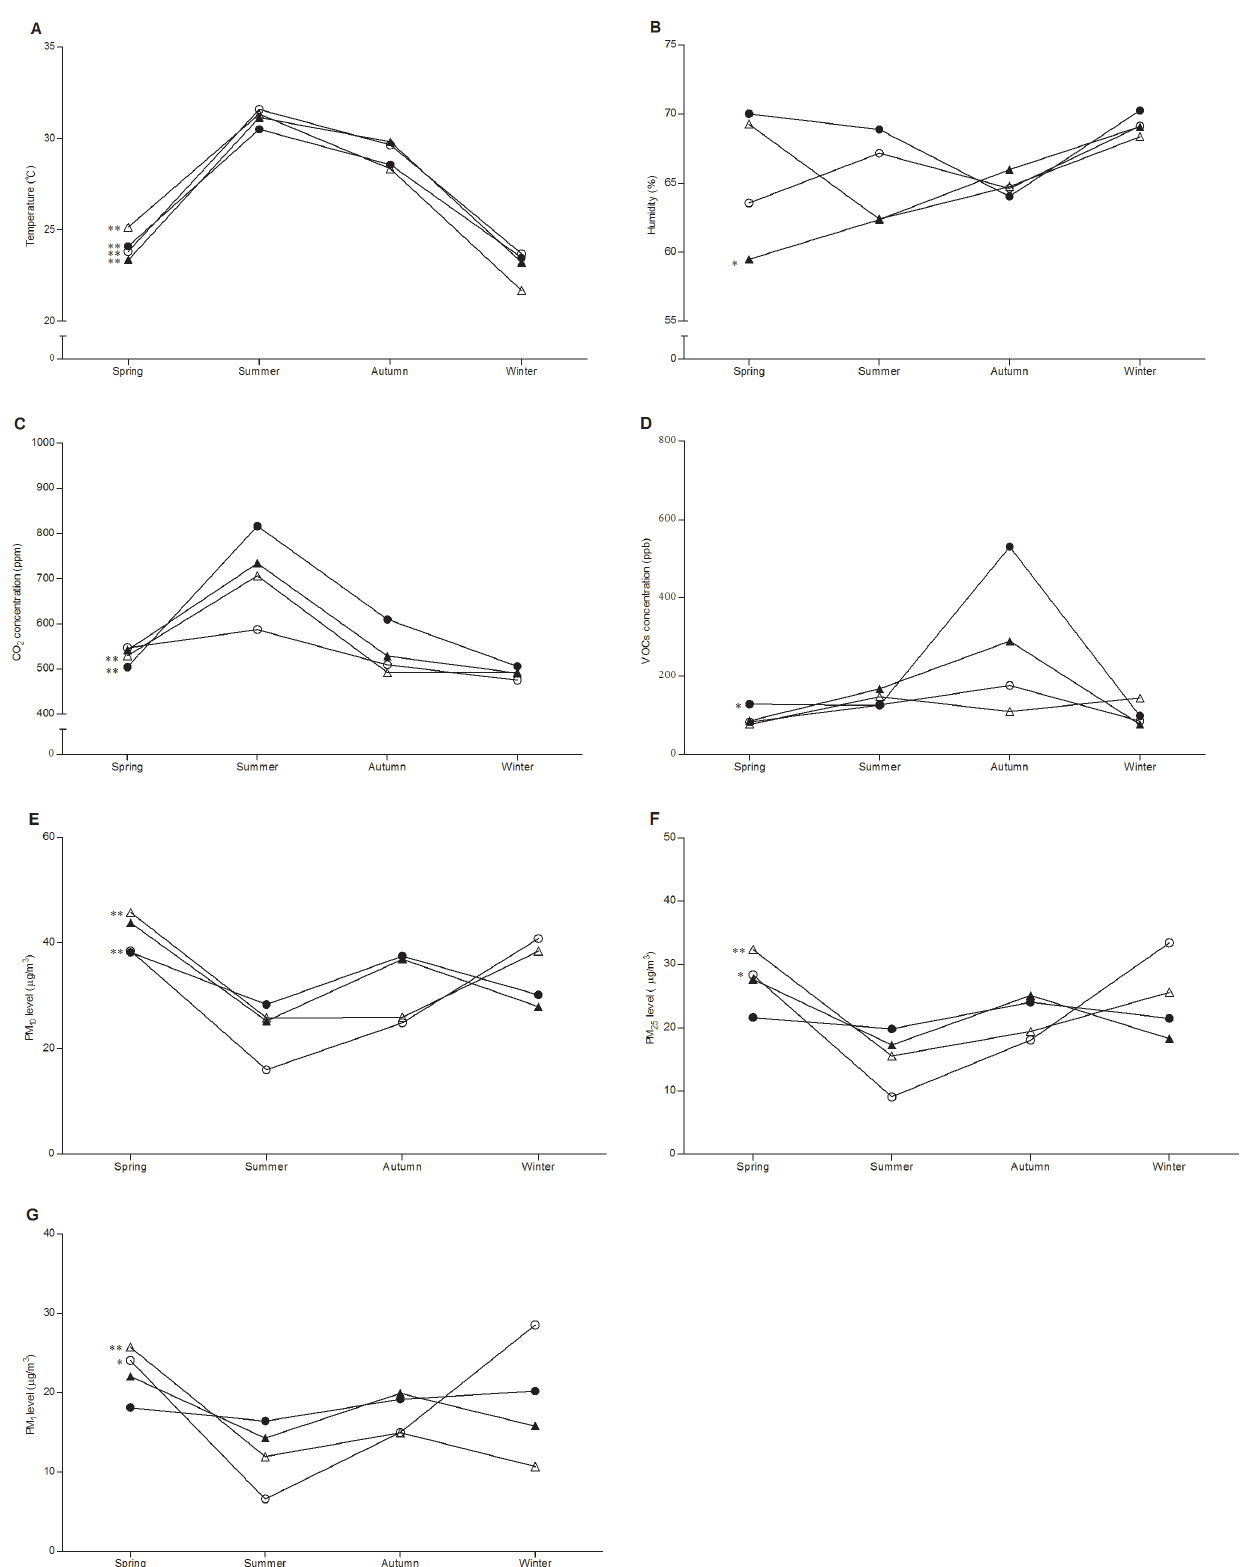
Figure 1. Seasonal variation of indoor air indices in children’s homes. *: p , 0.05; **: p , 0.01.